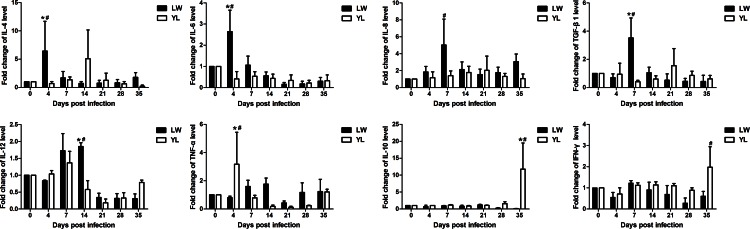
Changes in cytokine levels after PCV2 infection.The fold changes of cytokine levels in serum after PCV2 infection were calculated between LW-i and YL-i pigs. The levels of IL-4 (A), IL-6 (B), IL-8 (C), TGF-β1 (D) and IL-12 (E) in LW pigs were significantly increased at the early stage of PCV2 infection. The level of TNF-α (F) in YL pigs was significantly increased at 4dpi. And the levels of IL-10 (G) and IFN-γ (H) in YL pigs were significantly increased at 35 dpi. * P < 0.05 versus YL (or LW) group at same dpi, # P < 0.05 versus 0 dpi.